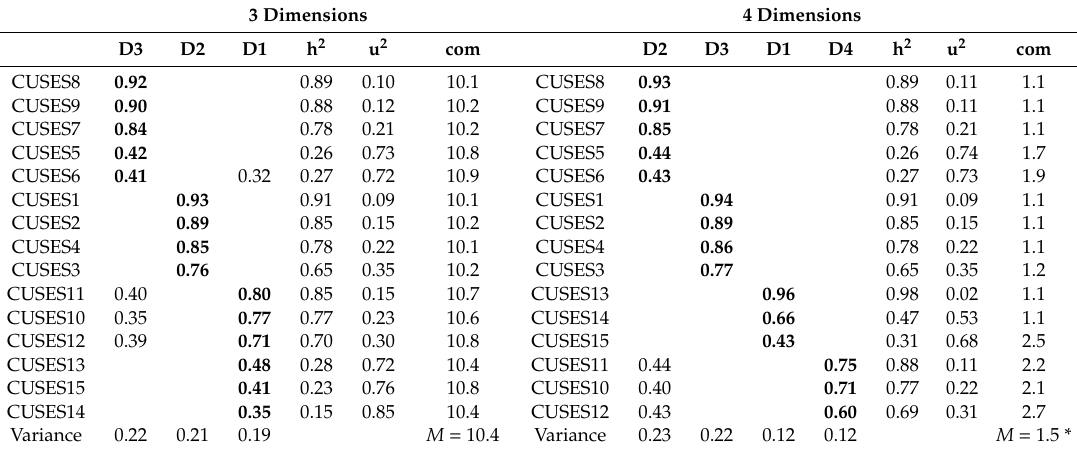
Table 2. Exploratory factor analysis based on the polychoric matrix using maximum likelihood and varimax rotation. 3 Dimensions 4 Dimensions